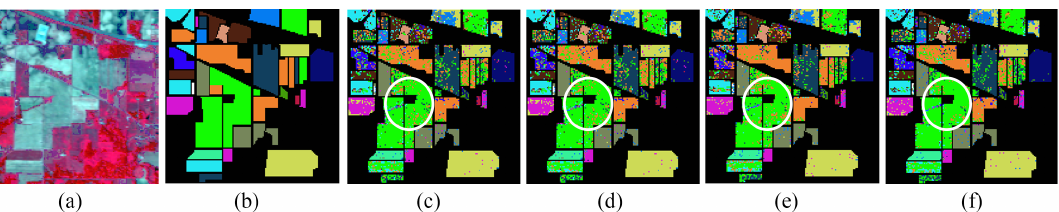
Figure 6. The classification maps of Indian Pines dataset: ( a ) the original dataset; ( b ) the ground truth labels; ( c ) classification map with the original dataset; ( d ) classification map with domain adaptation term; ( e ) classification map with self-attention mechanism; and ( f ) classification map with